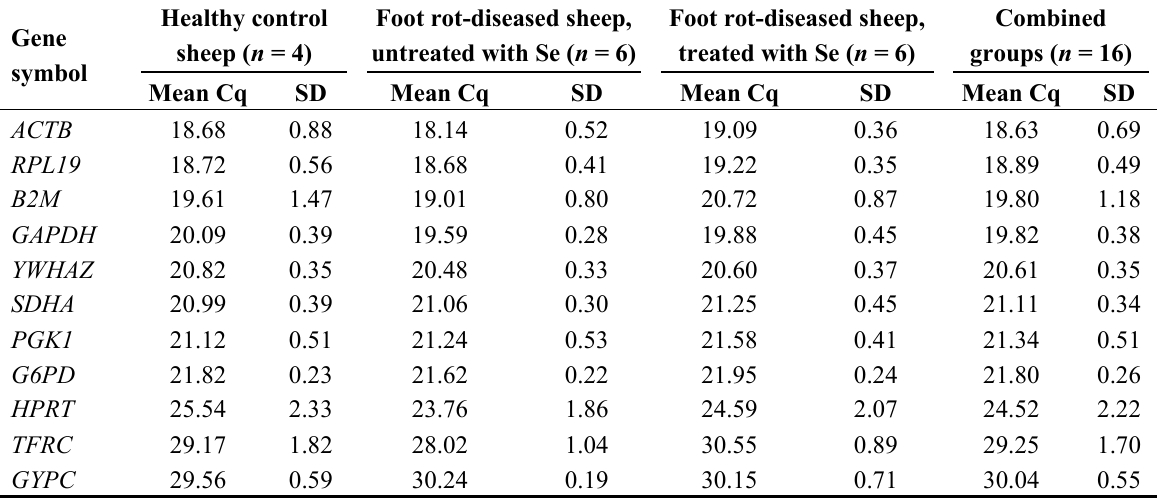
Table 2. Individual Cq values of the candidate reference genes in healthy control and foot rot-affected sheep, with or without selenium (Se) treatment, and combined groups.